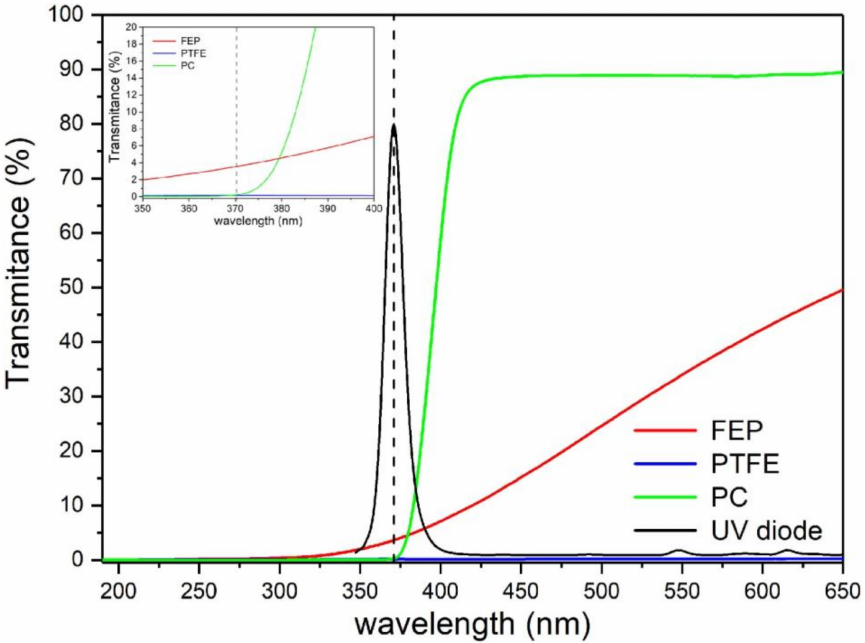
Figure 3. Comparison of transmittance as a function of wavelength for three different 2 mm thick plates of polymers: polytetrafluoroethylene (PTFE) (blue), polycarbonate (PC) (green) and FEP (red). Additionally, we present a UV diode spectrum range (black) that was employed in the model reactions (see Section 3.4). The dash line is main wavelength of the UV diode, λ = 371 nm. The inset demonstrates transmittance of the polymer plates in range 350 nm to 400 nm. The transmittance of the FEP plate is below 4%, whereas the transmittance of PTFE and PC are close to